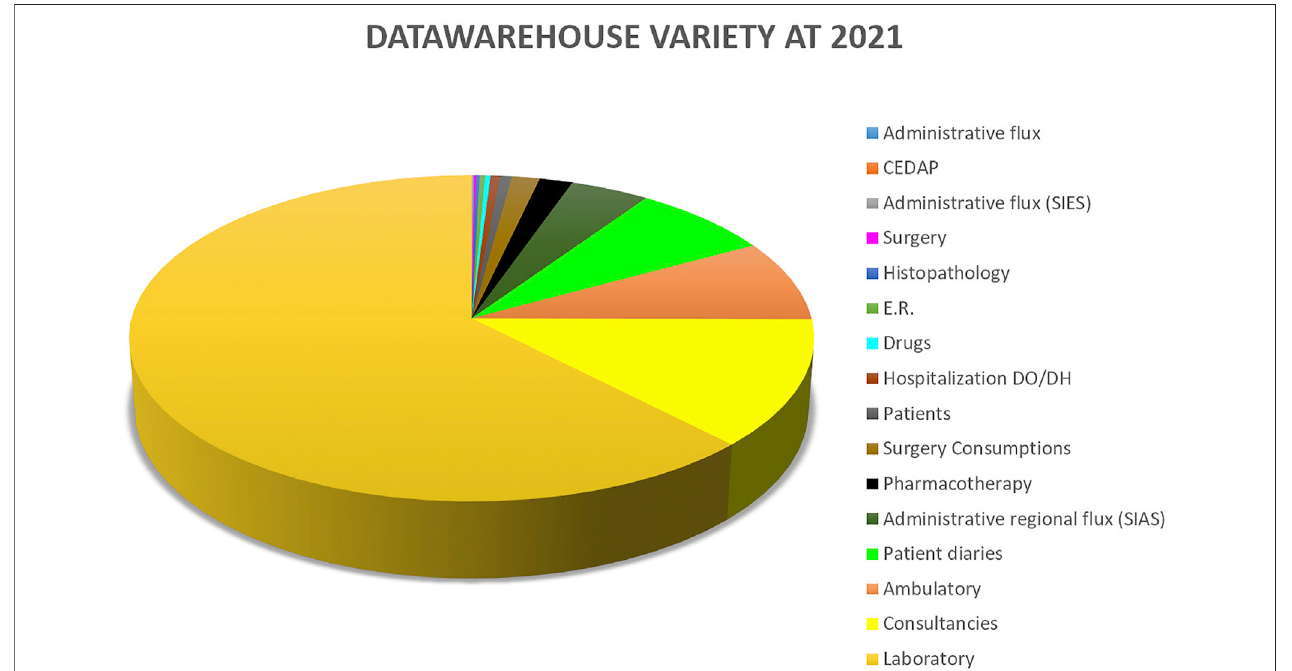
FIGURE 2 | Overview of the type of data available in the data warehouse to date.